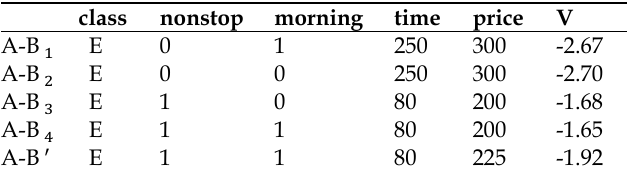
Table 1. A-B itineraries